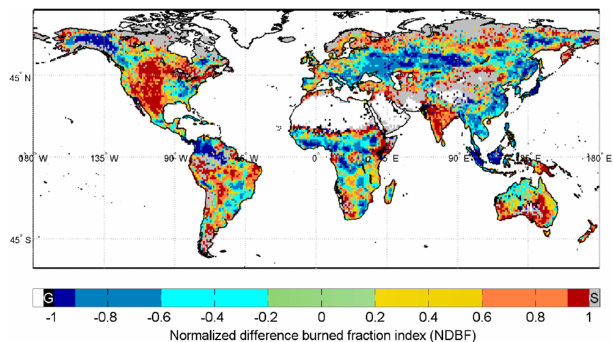
Figure 6. Discrepancies in the model outputs relative to GFED observation-derived data, as represented by the normalized differ- ence burned fraction index (see text). Black/grey colors represent grid cells in which fires only occur in GFED or SEVER.